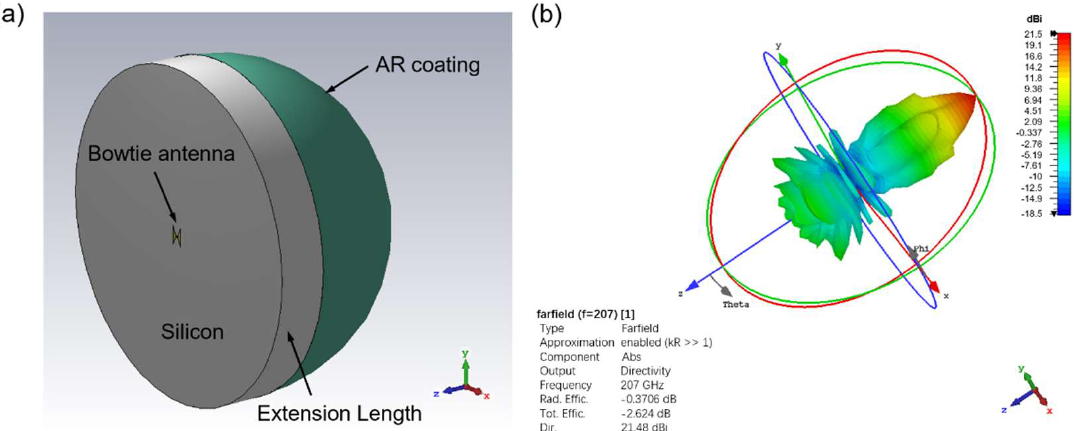
Figure 2. ( a ) Model of the hyper-hemispherical lens with bowtie feed in CST MWS. ( b ) Radiation pattern of the hyper-hemispherical lens with the radius of 4.5 mm at around 0.21 THz.